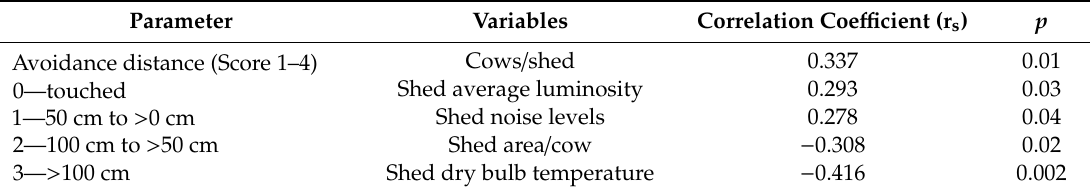
Table 5. Spearman’s rank correlations between mean shelter ( n = 54) avoidance distance scores of the selected cows and shelter-based welfare